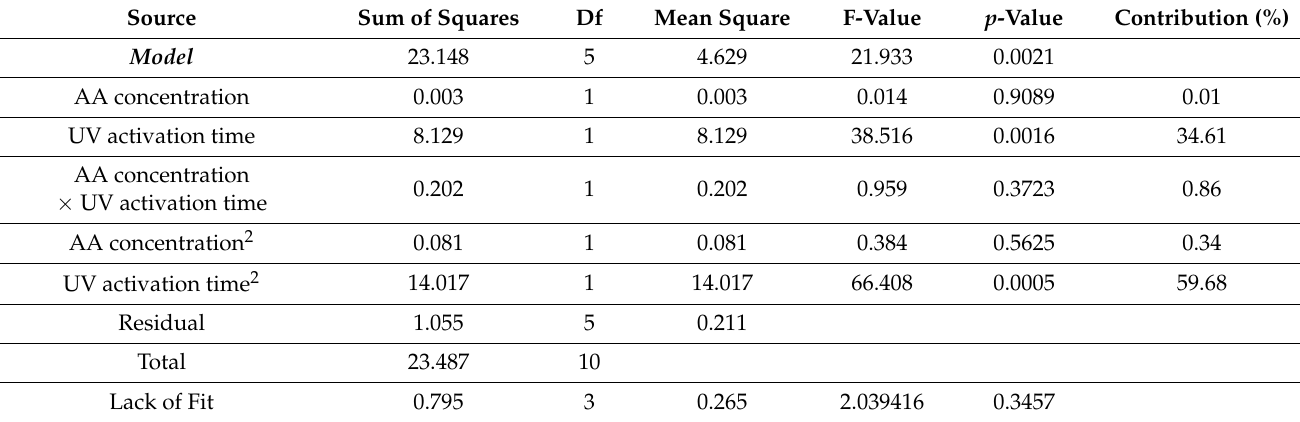
Table 6. ANOVA analysis for the salt rejection response.